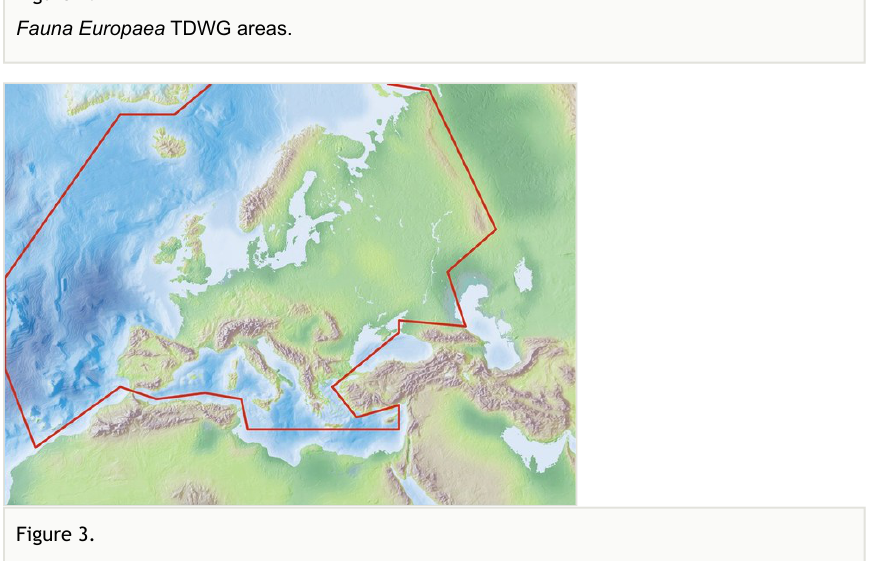
Figure 3. Fauna Europaea geographic coverage ('minimal